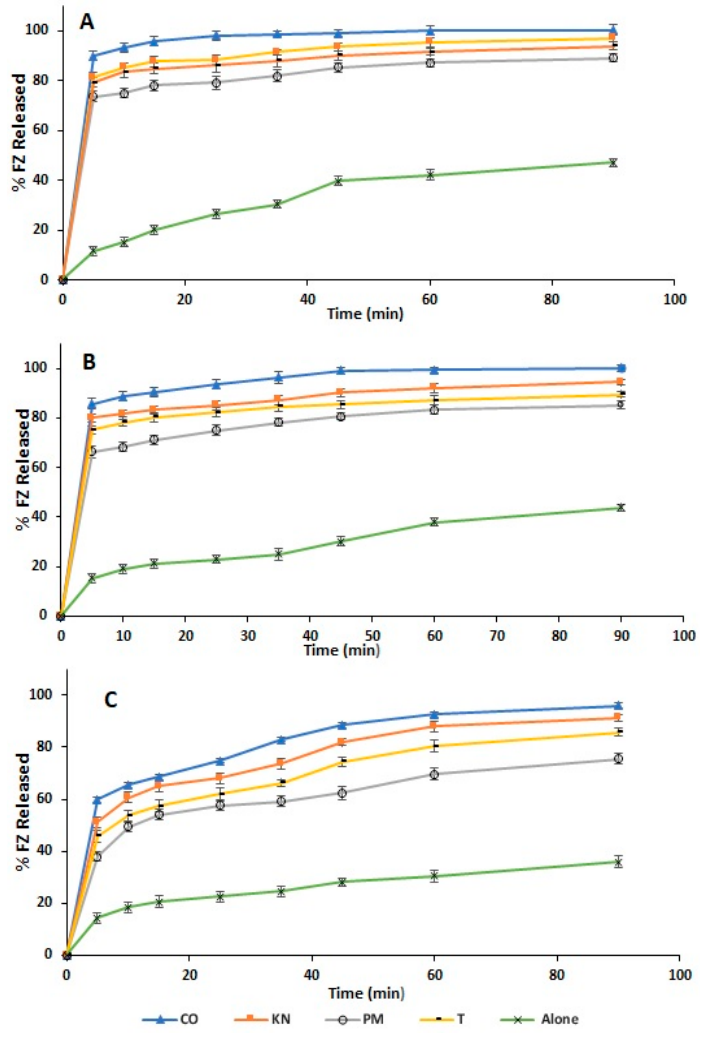
Figure 7. In vitro dissolution performance of the FZ to the differently prepared systems; co-evaporate (CO), kneaded (KN), physical mixture (PM), and FZ alone (FZ); in ( A ). pH 1.2, ( B ). phosphate buffer pH 7.4; ( C ). distilled water; Key: CO (filled triangle), KN (Filled square), PM (empty circle), and FZ alone (star); ( n = 3, ±S.D.).